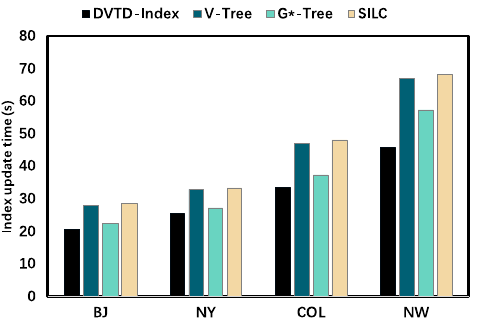
Figure 13. Comparison of update time between baseline algorithms and DVTG-Index.